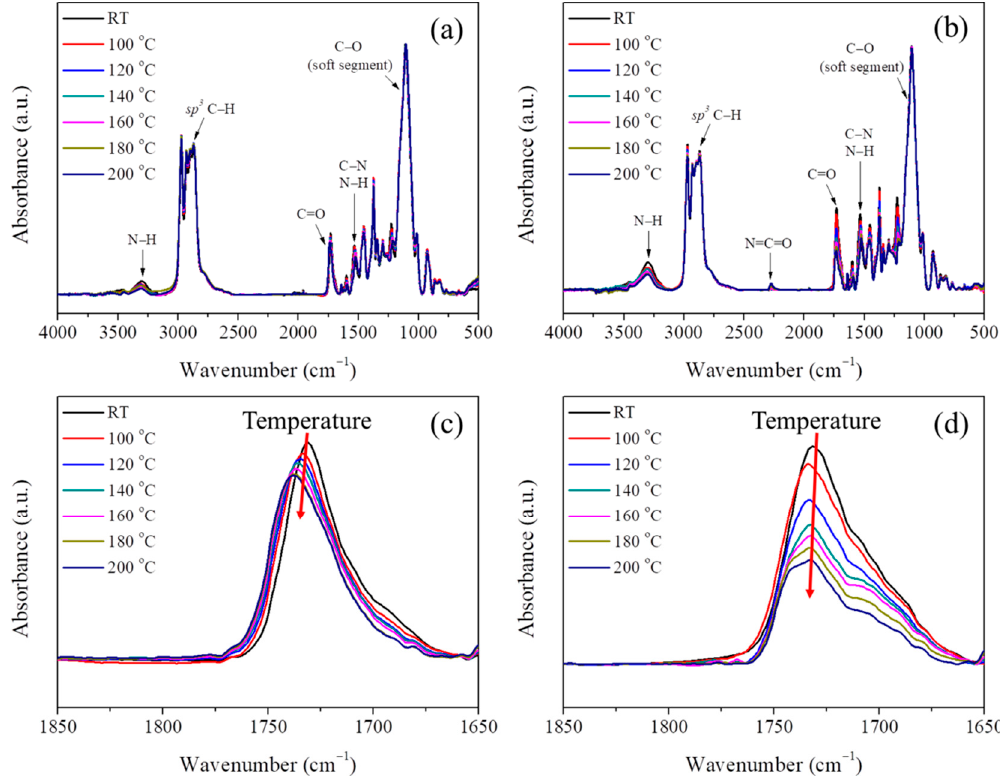
Figure 6. Temperature-dependent FTIR spectra of PU films: ( a ) PU-I0; ( b ) PU-I5; ( c ) PU-I0 expanded at 1650–1850 cm − 1 ; and ( d ) PU-I5 expanded at 1650–1850 cm − 1 .